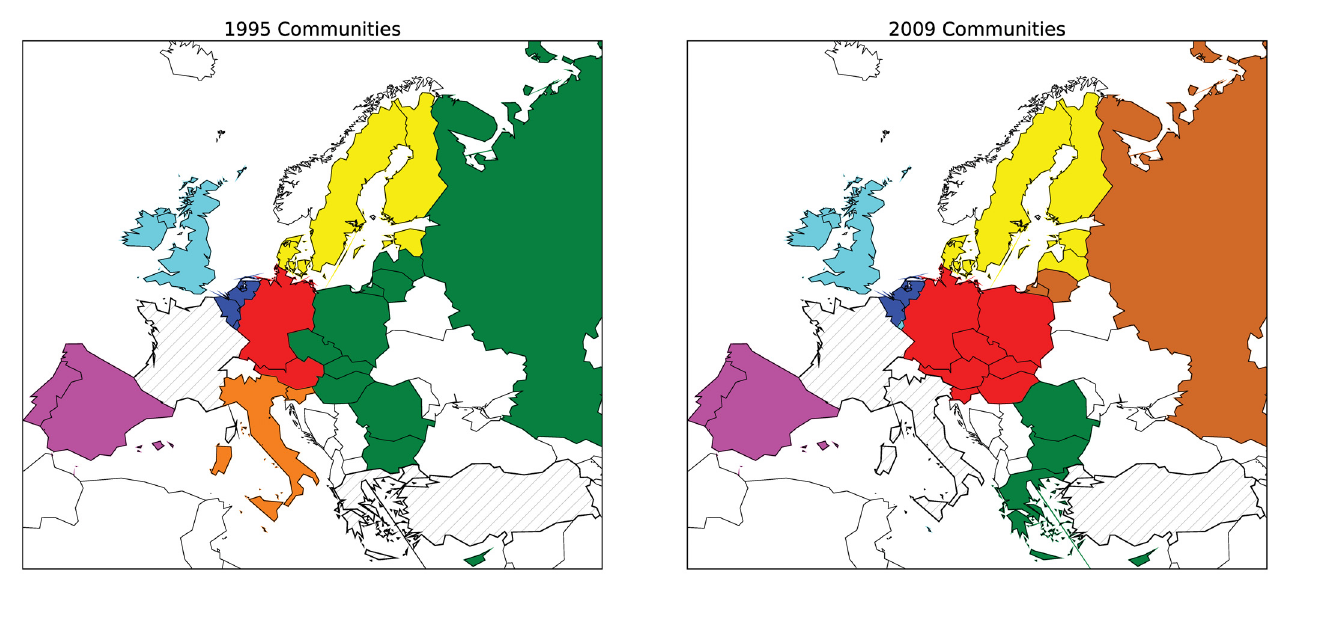
Fig 4. 1995 and 2009 Country-WION community structure. In this map countries of the same community are of the same color, with the exceptionof white countries(non-coloured countries),which are those that are not in the World Input-Output Dataset and dashed countries which are on the dataset but make a community on their own. It can be observedthat the communitiesin this network are mostly geographical and how the countries of the former Eastern Block changedtheir trade from Russia to